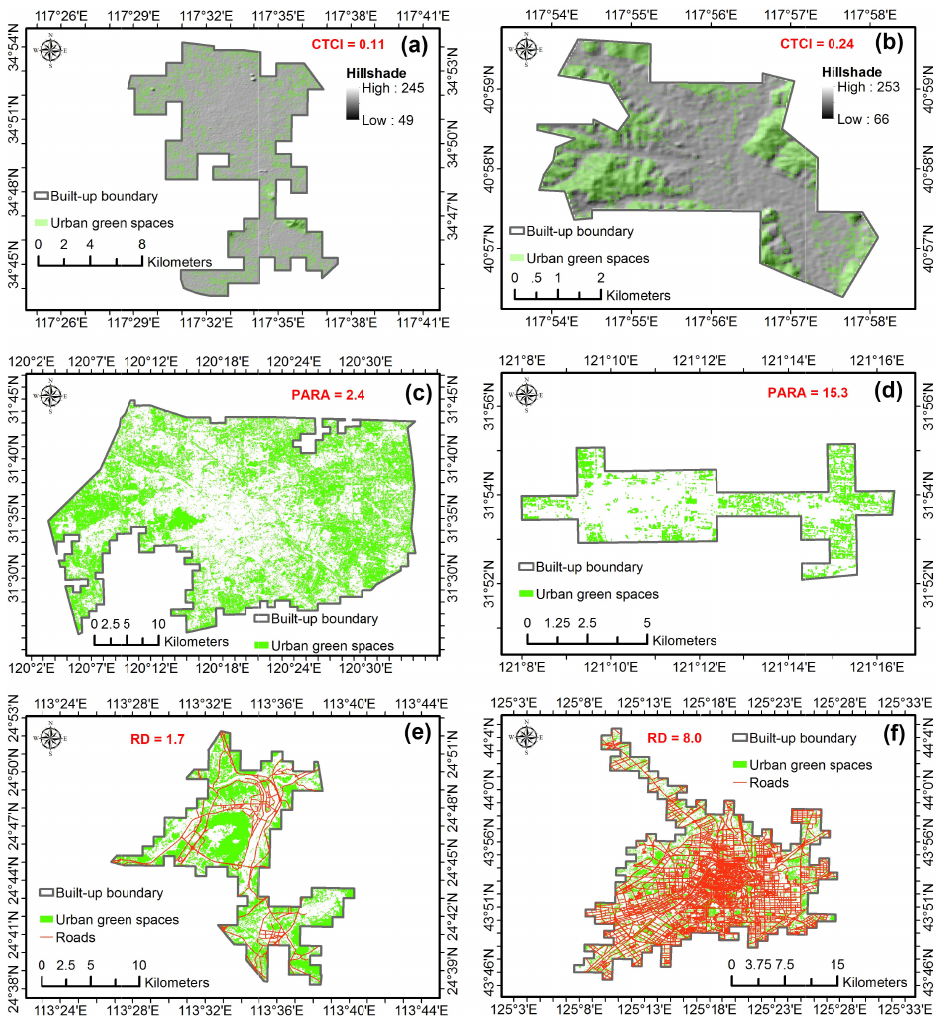
Figure 4. Examples of the distribution of urban green spaces and their landscape structures for cities with: ( a ) low compound terrain complexity index value (Zaozhuang, Shandong), ( b ) high compound terrain complexity index value (Chengde, Hebei), ( c ) low perimeter-area ratio value (Wuxi, Jiangsu), ( d ) high perimeter-area ratio value (Haimen, Jiangsu), ( e ) low road density (Shaoguan, Guangdong), and ( f ) high road density value (Changchun, Jilin). CTCI, compound terrain complexity index; PARA, perimeter-area ratio; RD, road